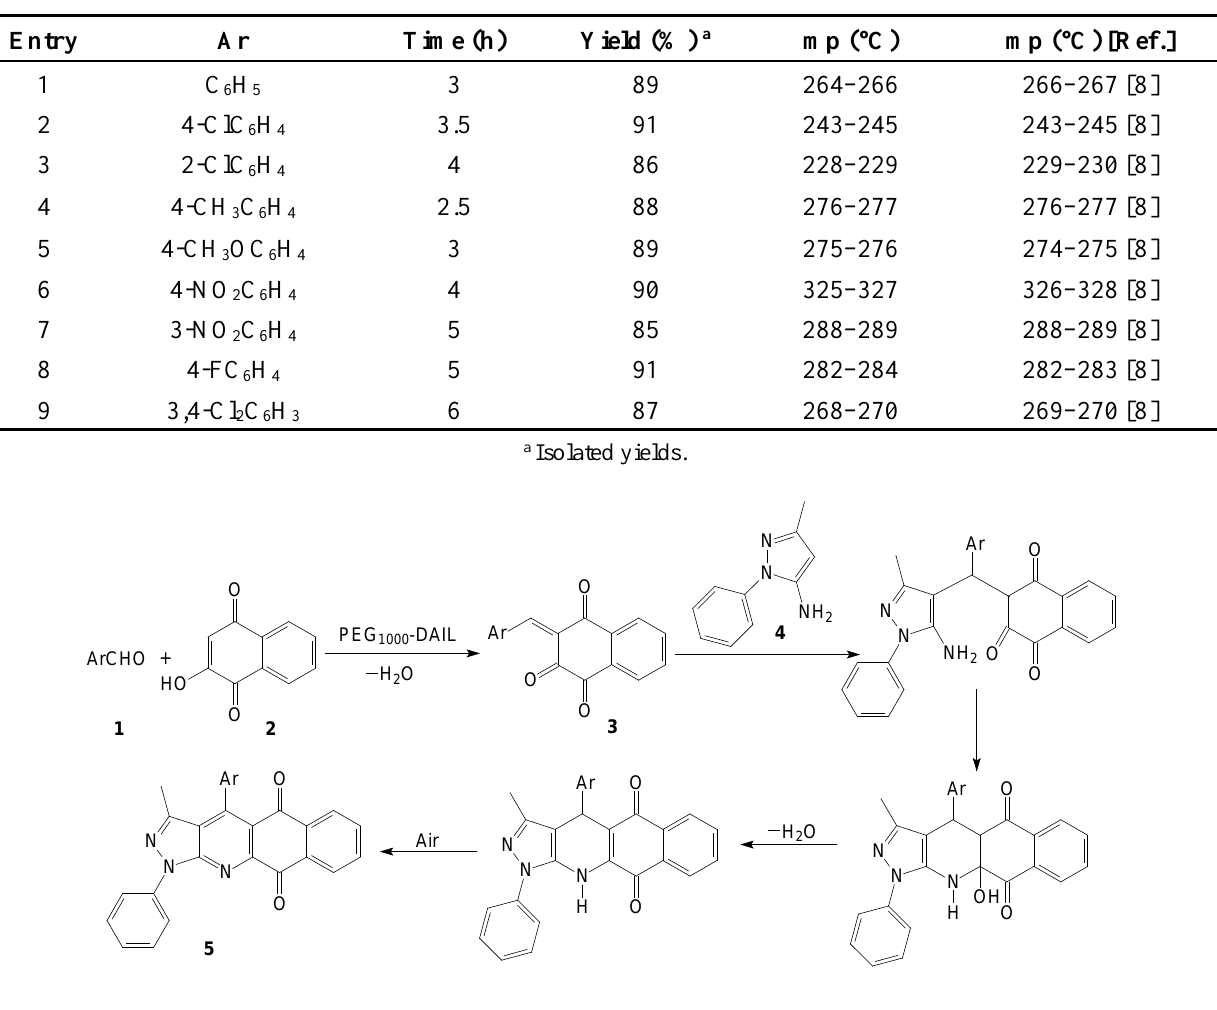
Table 2. PEG 1000 -DAIL catalyzed the synthesis of 4-aryl-3-methyl-1-phenyl-1 H